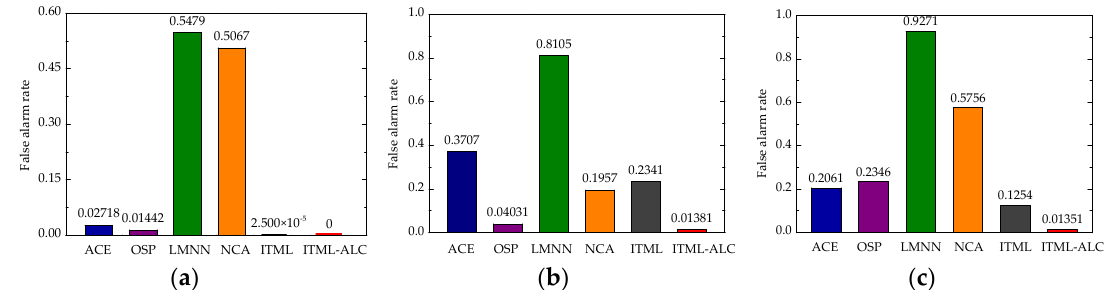
Figure 9. The FARs under 100% detection of the different algorithms. ( a ) AVIRIS LCVF dataset; ( b ) AVIRIS San Diego airport dataset; ( c ) HYDICE urban dataset. Figure 8. The AUCs of the different algorithms. ( a ) AVIRIS LCVF dataset; ( b ) AVIRIS San Diego airport dataset; ( c ) HYDICE urban dataset.